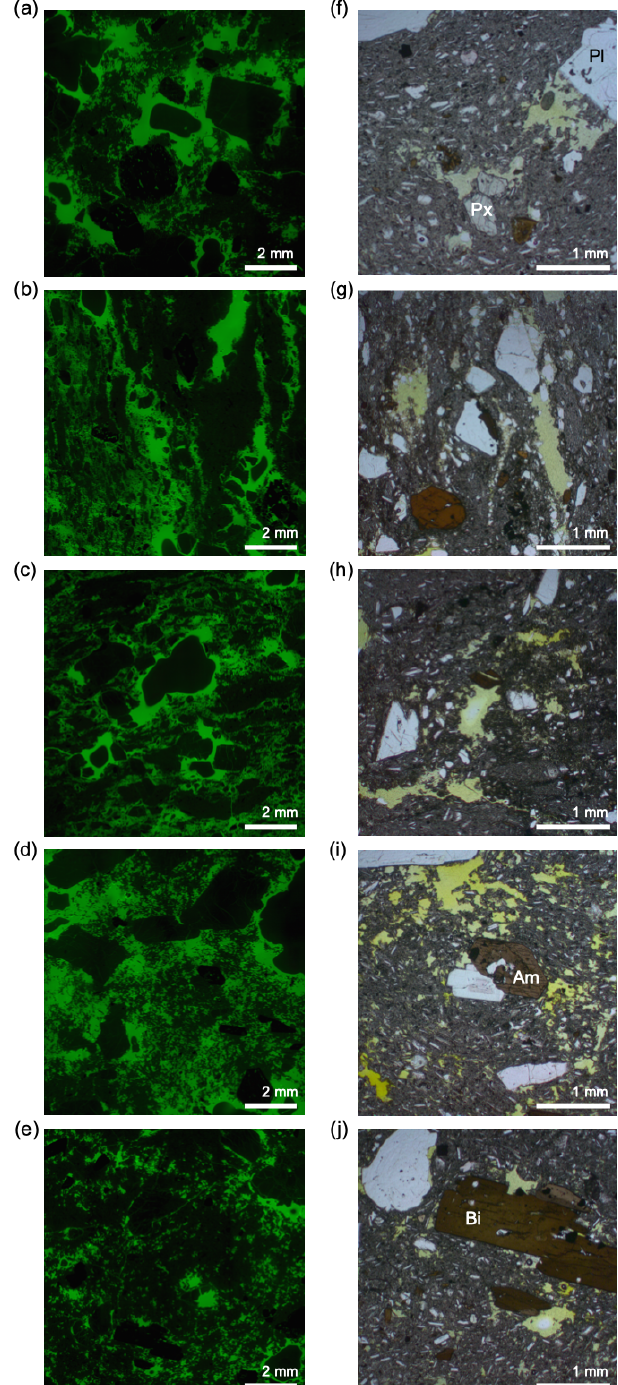
Figure 3. Images of thin sections in reflected light with a UV filter (a–e) and plane-polarised light (f–j) showing the range of textures of the tested materials: (a) UNZ1 has pore space concentrated around phenocrysts, occasional sub-rounded vesicles, and a relatively dense groundmass that hosts occasional fractures of 0–20µm width, up to ∼ 2 mm in length; (b) UNZ9a hosts pore space concentrated in laterally extensive bands in the orientation of cataclastic fabric observable in the hand specimen (vertical), which are interspersed by denser bands, pores border angular fragmental crystals; (c) UNZ9b shows the same textures as in UNZ9a, here orientated horizontally, and fine fractures are additionally visible within the groundmass and broken phenocrysts (note the large rounded black patch in the centre is a poorly impregnated pore, not a sub-rounded phenocryst); (d) UNZ13 has distinguishing sub-rounded vesicles in the groundmass and concentrated around phenocrysts, phenocrysts occasionally host a number of very fine fractures (note the large rounded black patch at the top right is a poorly impregnated pore); (e) UNZ14 shows smaller pores more distributed but still localised adjacent to phenocryst, occasional thin ( < 10 µ m ) fractures of up to ∼ 10mm propagate through the groundmass connecting phenocrysts, which themselves are highly fractured (with hairline fractures). Transmitted light images (f–j) allow the identification of plagioclase (Pl, > 25vol% ), amphibole (Am, ∼ 5vol% ), biotite ( ∼ 5vol% ), and pyroxene (Px, < 2vol% ) phenocrysts and microphenocrysts (quartz is present but not shown), and glassy groundmass with microlites of plagioclase, pyroxene, quartz, amphibole, and iron-titanium oxides of 10–100µm ( ∼ 30vol% ). Plagioclases show occasional zoning (i) and concentric bubble trails ( f and j ). The cataclastic samples UNZ9a (g) and UNZ9b (h) additionally have broken crystals, most frequently plagioclase that forms trails parallel to elongate porosity-rich bands, and the groundmass shows heterogeneously distributed light and dark zones. Solid Earth, 12, 633–664,